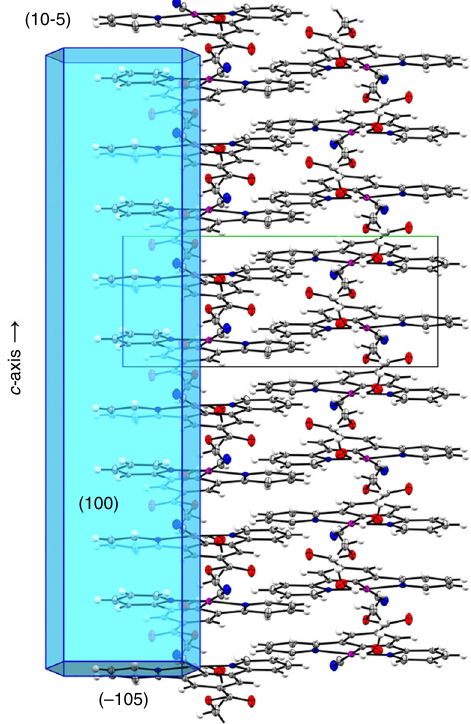
Fig. 5 Solid-state Pt – Pt stacking in Form-I. The image shows the reconstruction of the natural crystal faces superimposed onto the crystal structure of Form-I, which con fi rms that the long axis of the needle-like crystallites is coincident with the Pt … Pt stacking direction ( c direction, vertical). The crystal faces were determined by face-indexing a red needle of